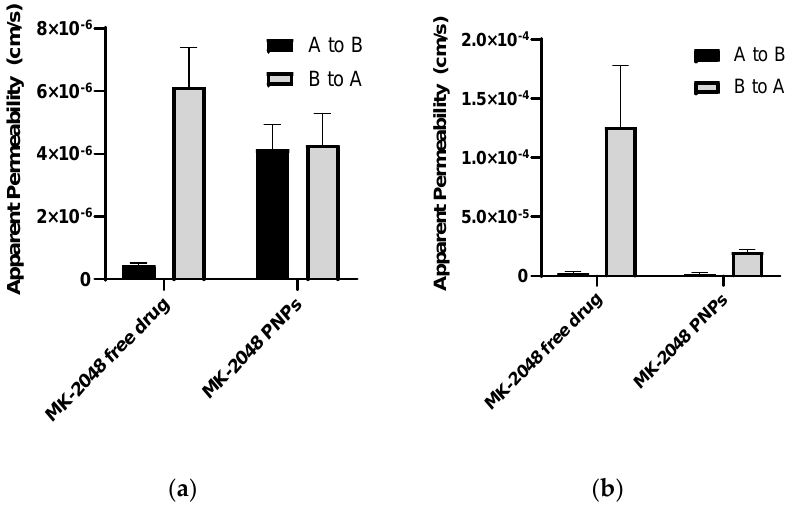
Table 2. Efflux Ratio (ER) values in two transporter-overexpressed cell lines.